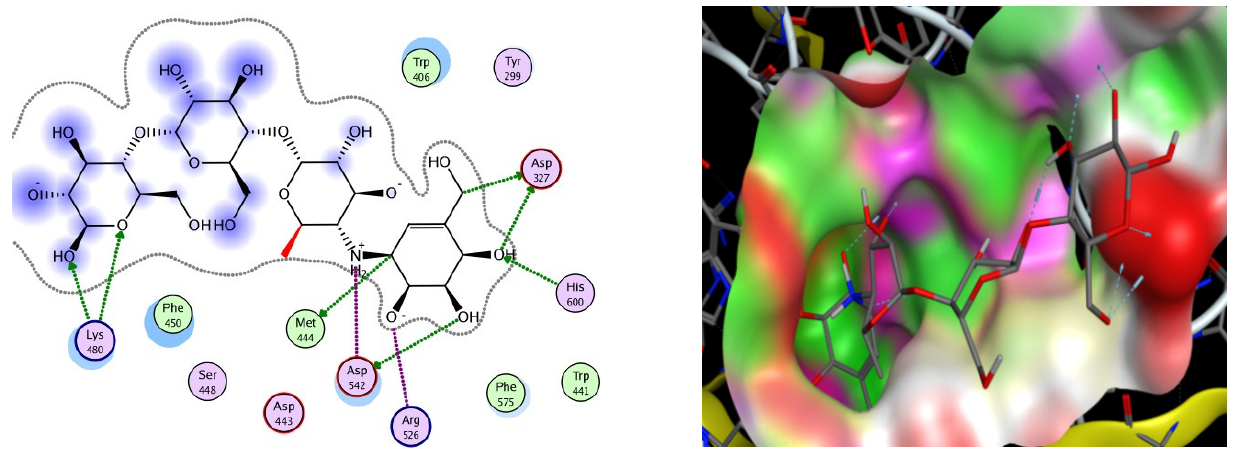
Figure 4. 2D ( Left ) and 3D ( Right ) interaction modes of the standard drug,